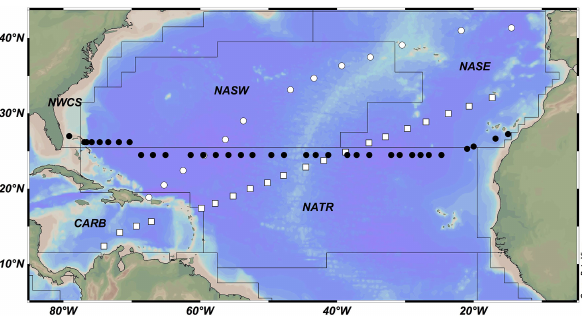
Figure 1. Map showing the stations occupied in Leg 1–winter (black circles), Leg 2–spring (white circles) and Leg 3–summer (white squares) during the Malaspina 2010 Expedition and the Longhurst Provinces crossed in the